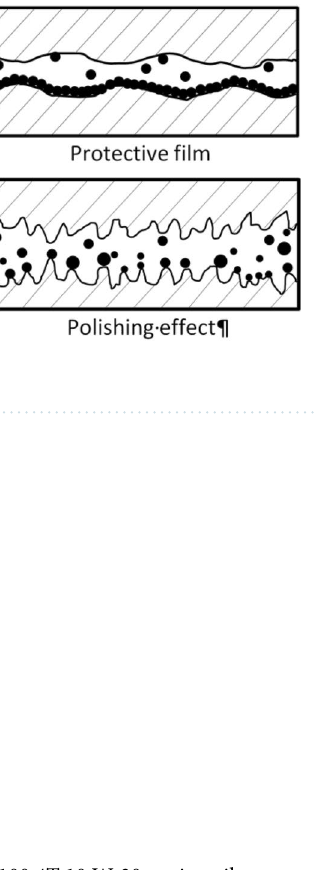
Table 1. Properties of commercial TiO 2 Degussa P25 and Motul 5100 4T 10 W-30 engine oil.